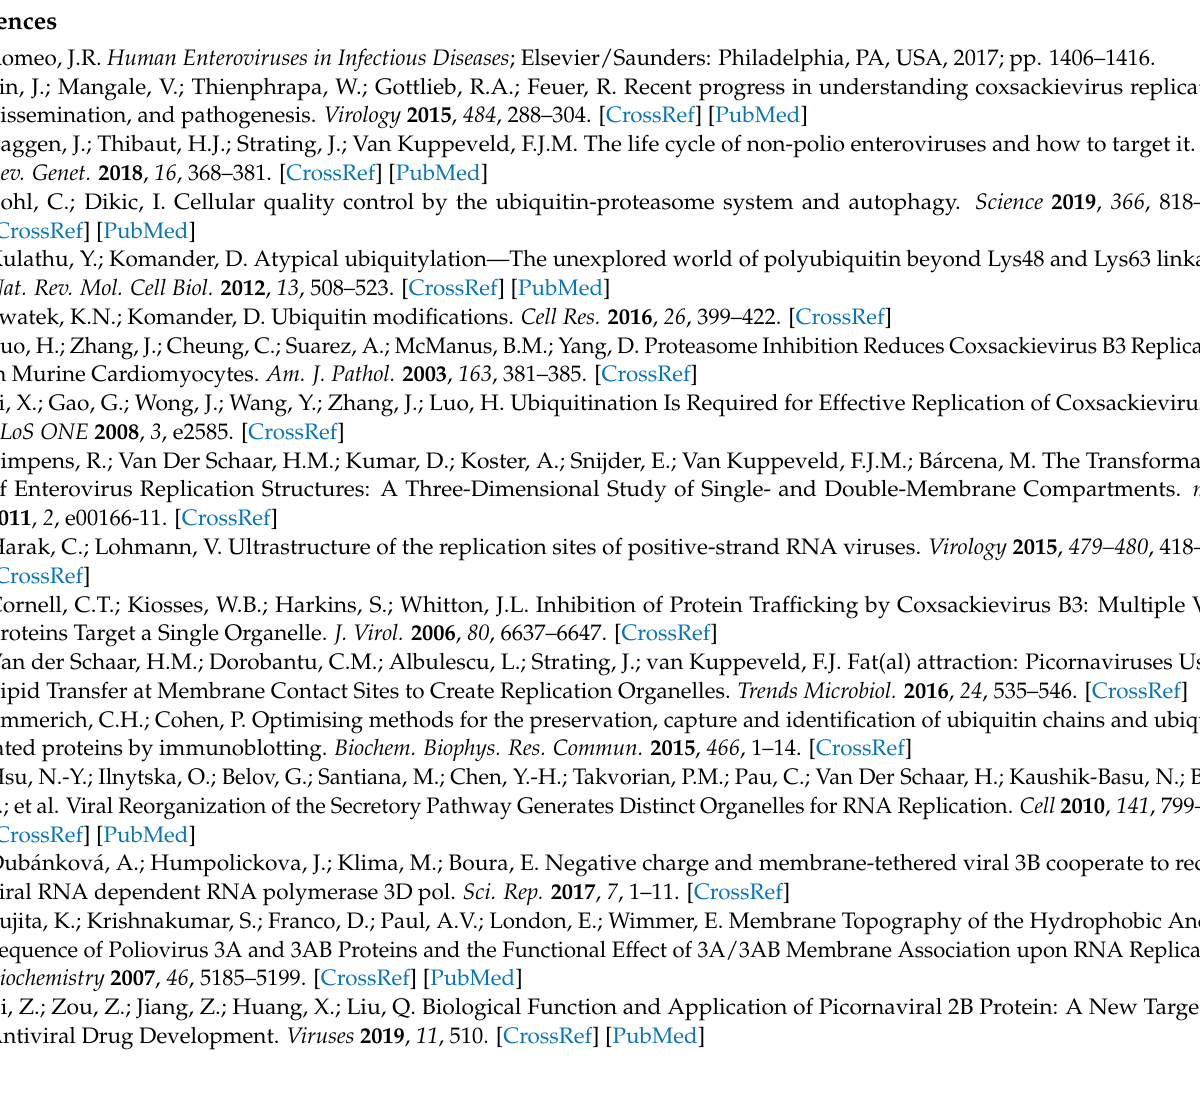
Figure S2: CVB3 protein 3A increases permeability of cellular membranes for Ca 2+ ions, Figure S3: effect of proteasome and lysosome inhibitors on CVB3 replication, Figure S4: effect of proteasome and lysosome inhibitors on CVB3 polyprotein